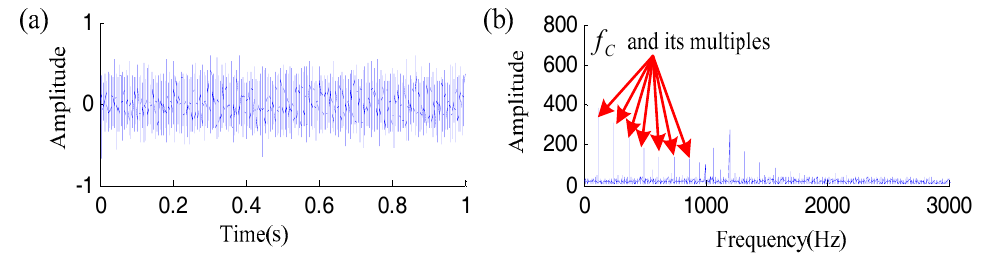
Figure 7. Time and Hilbert envelope demodulation spectrum of the extracted periodic impulse signal. ( a ) The waveform of the extracted periodic impulse signal in the time-domain. ( b ) The Hilbert envelope demodulation spectrum of the extracted periodic impulse signal.